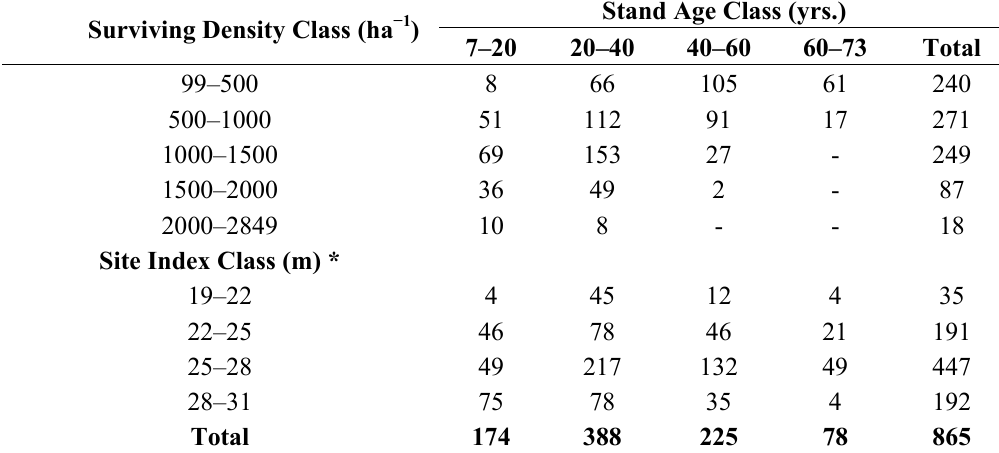
Table 2. Distribution of observations by age, site index and surviving density for 267 permanent longleaf pine plots measured (thinned and